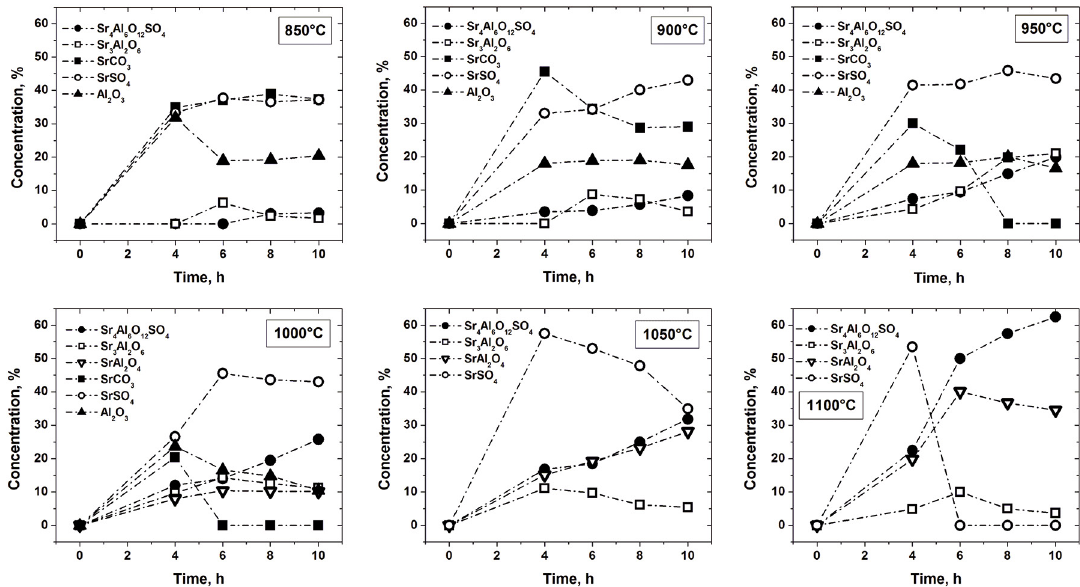
Figure 1: Formation of strontium compounds and starting reagents, quantified by X–ray powder diffraction data for samples of the 3Al O :3SrCO :SrSO mixture, heat treated at several temperatures and isotherms. 2 3 3 4 in the temperature range from 850 to 1100°C and